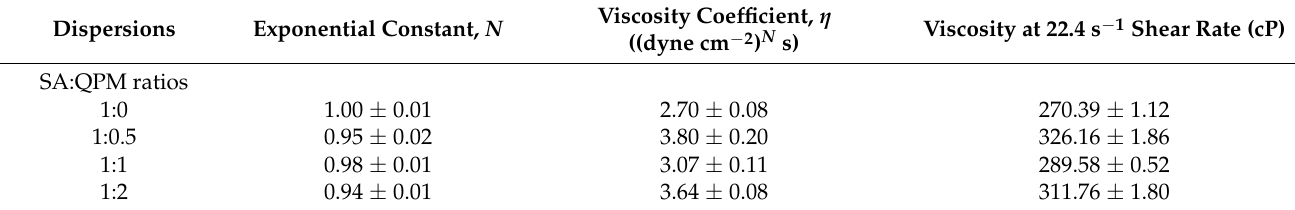
Figure 4. Rheograms of SA and SA-QPM dispersions. Each value is the mean ± S.D., n = 3. Table 1. Rheological property and viscosity of SA and SA-QPM dispersions.